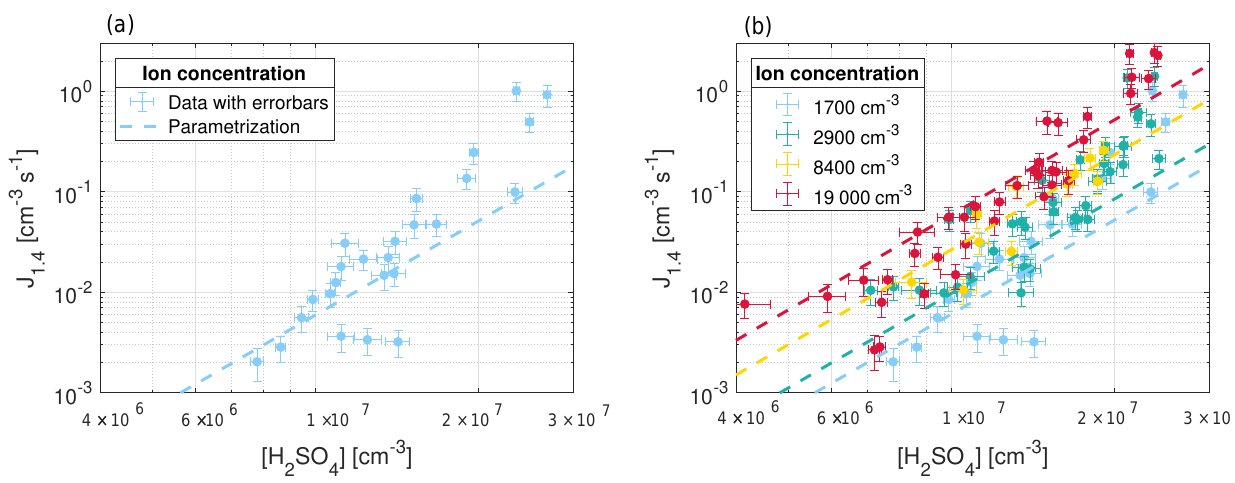
Figure 6. Parameterization from Gordon et al. (2017) with [NH 3 ] = 2.2ppb (dashed lines) and nucleation rate measurements from this study at T = 295K, RH = 38%, N = 1700cm − 3 (a) and all N (b)